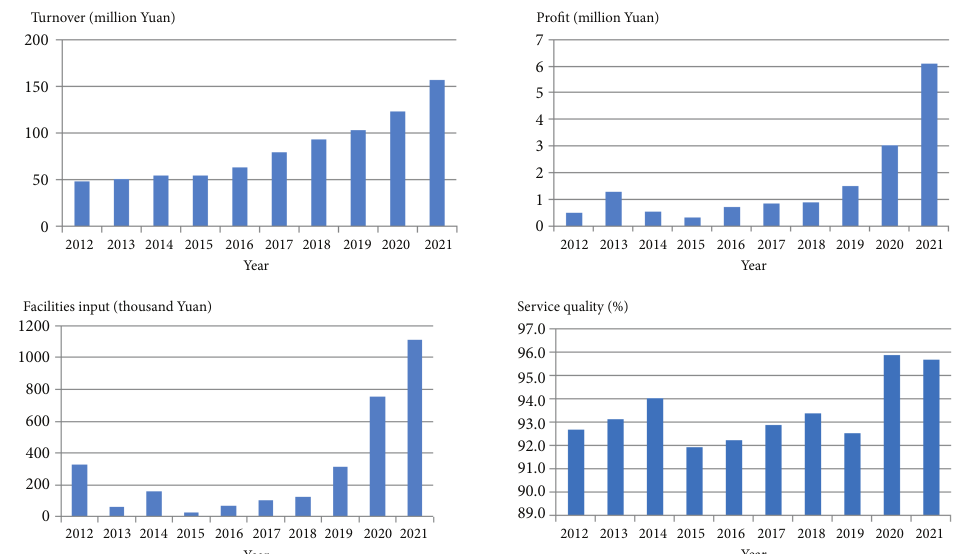
Figure 5. Changes in the main indicators of Sapphire Service in the past ten